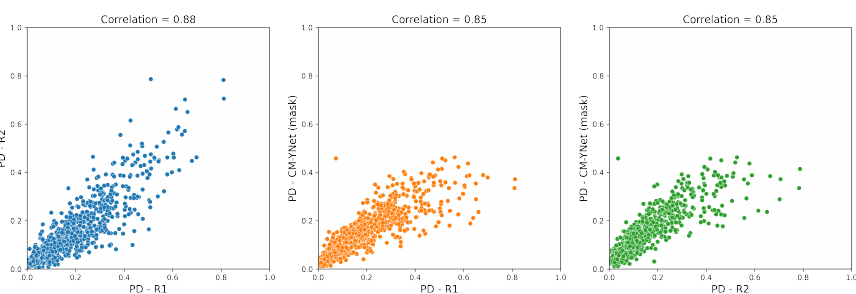
Figure 8. Correlations between the breast percent density (PD) calculated by our CM-YNet (mask) method and the radiologists’ annotations (R1 and R2).